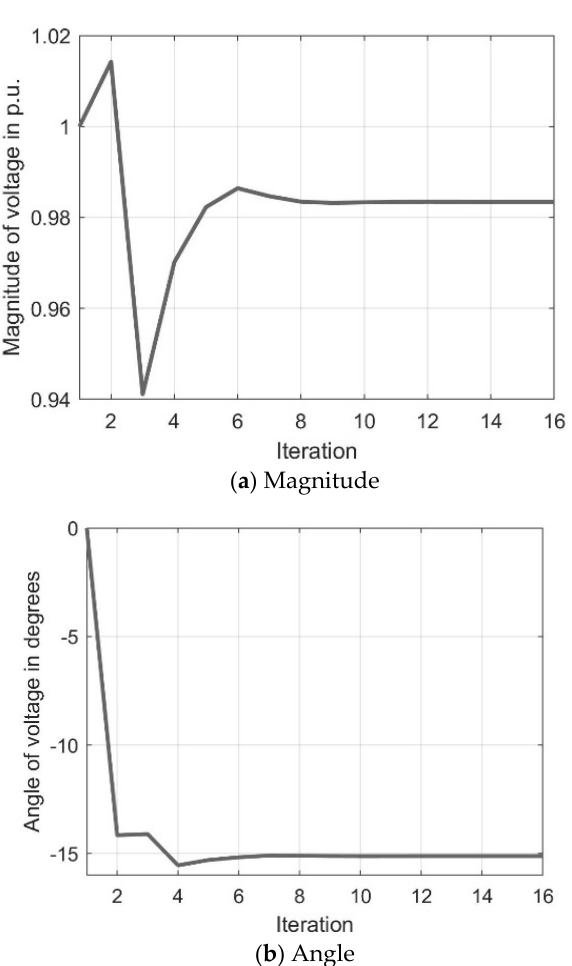
Figure 10. Convergence of the voltage of bus 7.